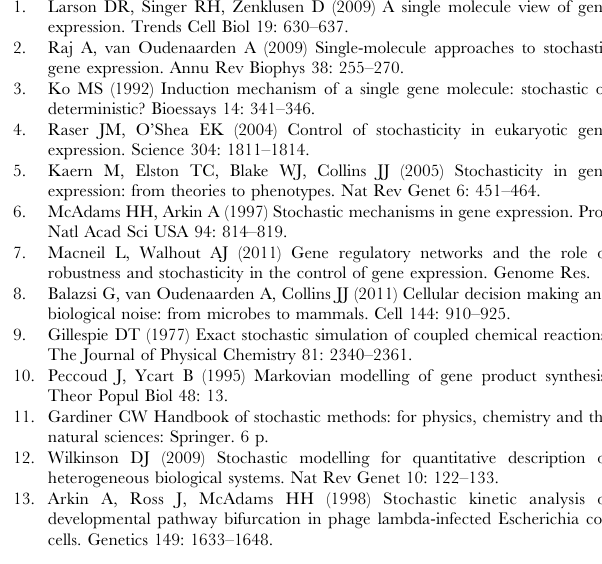
Figure S2 Dynamical fluctuations of simulated trajec- tories by MCM. (a) At the steady state and [dox] =0.5 m g/ml, two time-series trajectories of two ‘‘single cell’’ stochastic simulations, randomly selected from 10,000 individual computer runs. (b) The corresponding telegraphs. Under this condition, the stochastic simulations of cell population exhibit switch-like patterns by the 3-state MCM (Figure 3b) or graded responses by the 2-state MCM (Figure S1). Three different types of horizontal red lines are drawn to denote the three states of transcription levels. (TIF) Figure S3 Averaged dynamical fluctuations of 10000 simulated trajectories by 3-state MCM. Simulation was carried out in three different [dox] conditions. The duration of this stochastic simulation is set from 0 to 201 time cycles. (TIF) File S1 Details about the modeling of experimental results reported in Rossi et al. (2000) by conventional method. Table S1 Estimated parameter